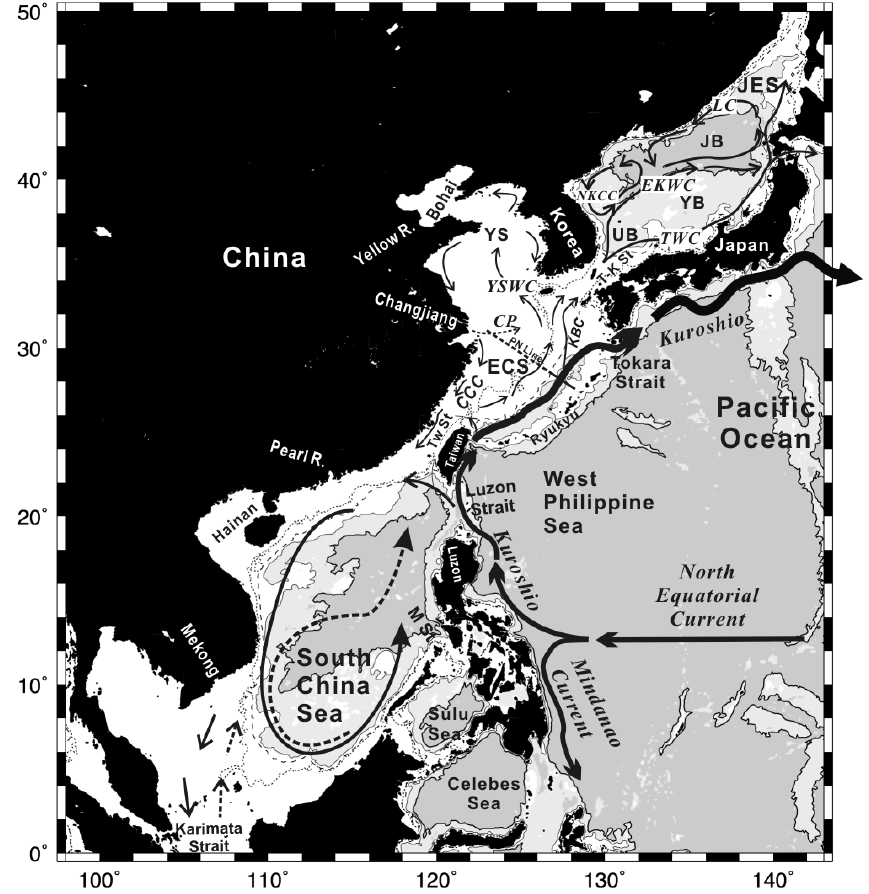
Figure 1. Marginal seas in the western North Pacific Ocean. The contours are isobaths of 100m (dotted), 200m (dashed), 1000m (thin solid) and 3000m (thick solid). Sea floor deeper than 3000m is shaded in grey. The Kuroshio is the strong western boundary current that flows through this region and interacts extensively with the three major marginal seas, namely, the South China Sea (SCS), East China Sea (ECS) and the Japan/East Sea. The ECS connects with the Yellow Sea, which in turn connects to the Bohai Sea, forming one of the largest contiguous continental shelves in the world. Four large rivers empty into the continental margins. The Mekong and the Pearl River discharge into the SCS; the Changjiang river discharges into the ECS, forming a distinct large river plume (Changjiang plume, CP) in summer; the Yellow River discharges into the Bohai Sea. The circulations within the marginal seas change seasonally. The stronger winter monsoon usually drives stronger currents, which are shown in solid curves. However, the weaker summer monsoon does cause some changes in currents; the more notable ones are shown as dashed curves. See Table 1 for